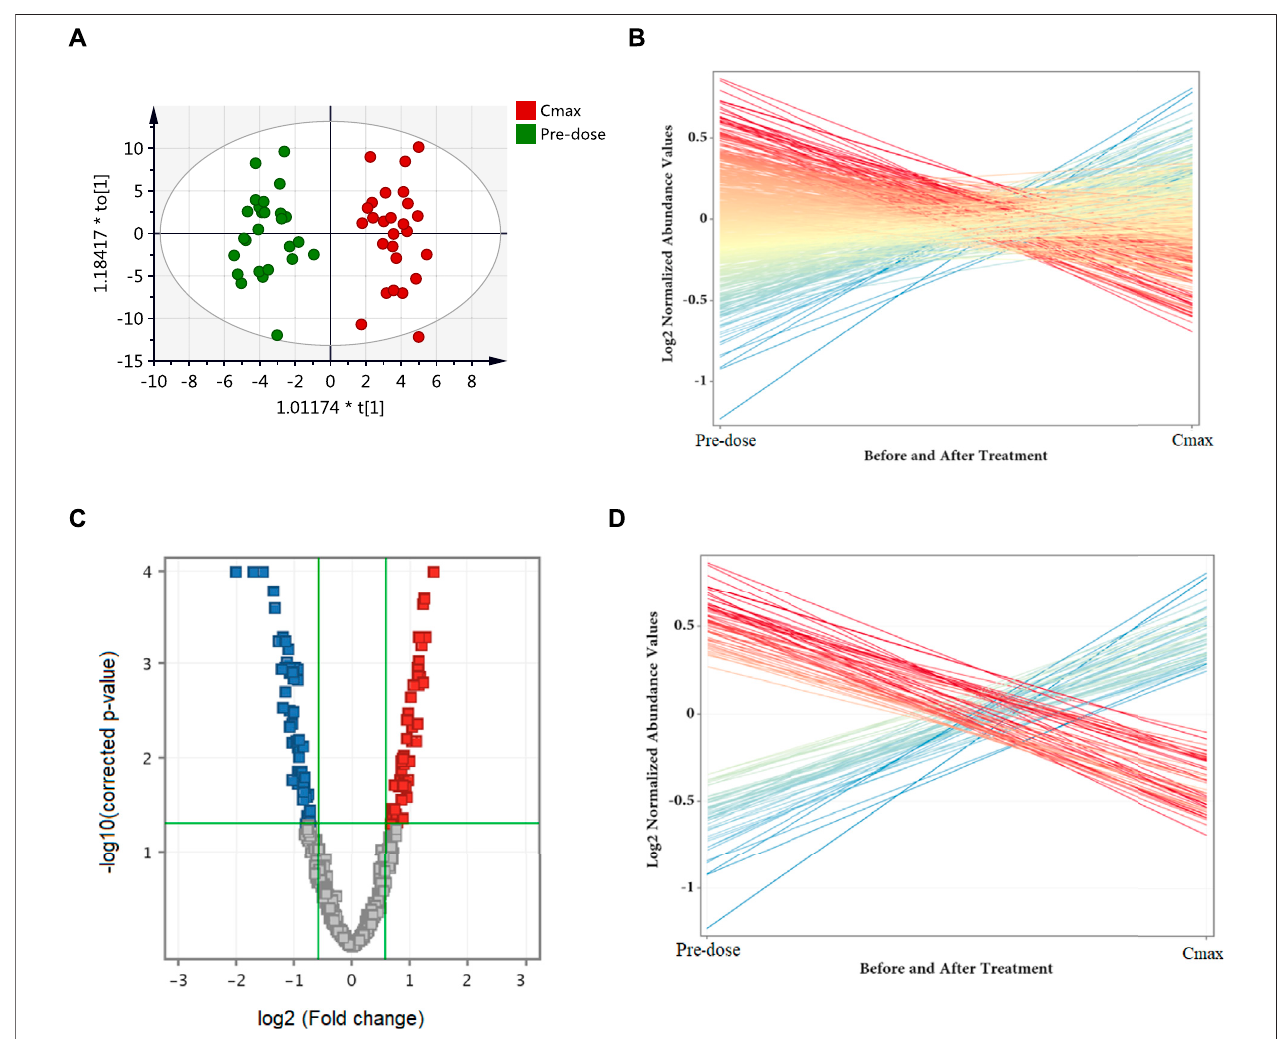
FIGURE2| Differentiallyexpressedmetabolitesasofmetforminadministrationbasedonabinarycomparisonbetweenbaselinelevel(pre-dose)andC max level. (A) OPLS-DA (R2X (cid:2) 0.26, R2Y (cid:2) 0.92, Q2 (cid:2) 0.62) scores plot of the metabolic pro fi le of serum samples obtained from 26 subjects pre-dose (green) and at C max (red). (B) Outofthe734identi fi edmetabolites,111weresigni fi cantlydysregulated(presentedasredandbluelines)whiletheremainingwereunchanged(yellowlines). (C) Volcano plot ofup (red, n (cid:2) 57) and down (blue, n (cid:2) 54) regulated metabolites. (D) The differentially altered metabolites as of metformin administration. Blue and red refer to up-and down-regulated metabolites,